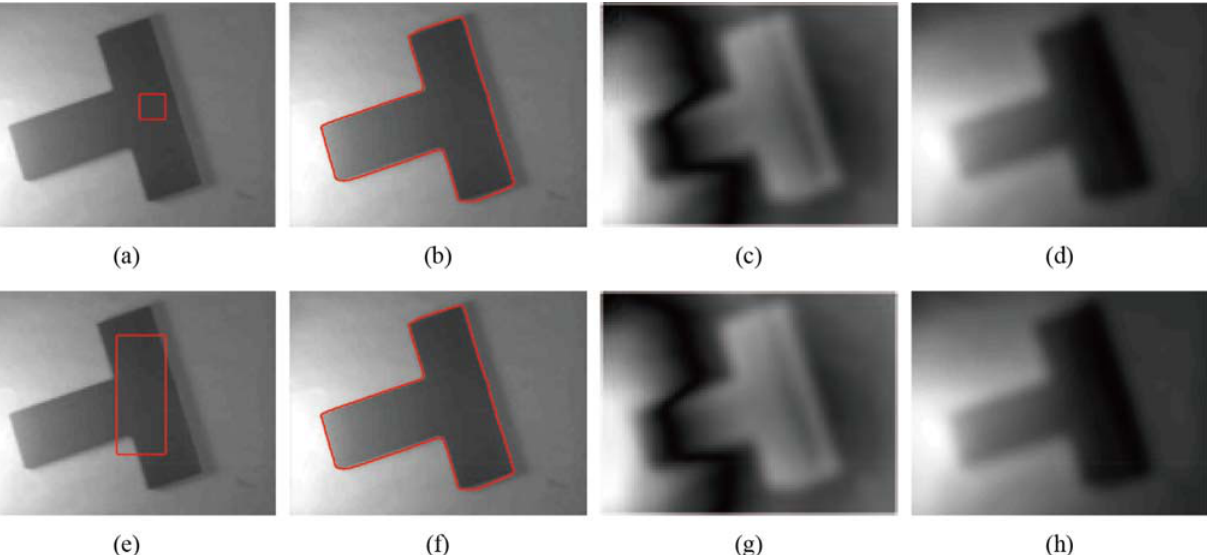
Fig 4. Experimental results of our model. (a), (e) The original image with red initial contours. (b), (f) The final segmentation results of our model. (c), (g) The gray images of j d j . (d), (h) The estimation of the bias field in our